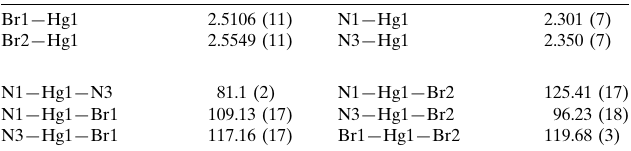
Selected geometric parameters (A˚ , (cid:2) ).